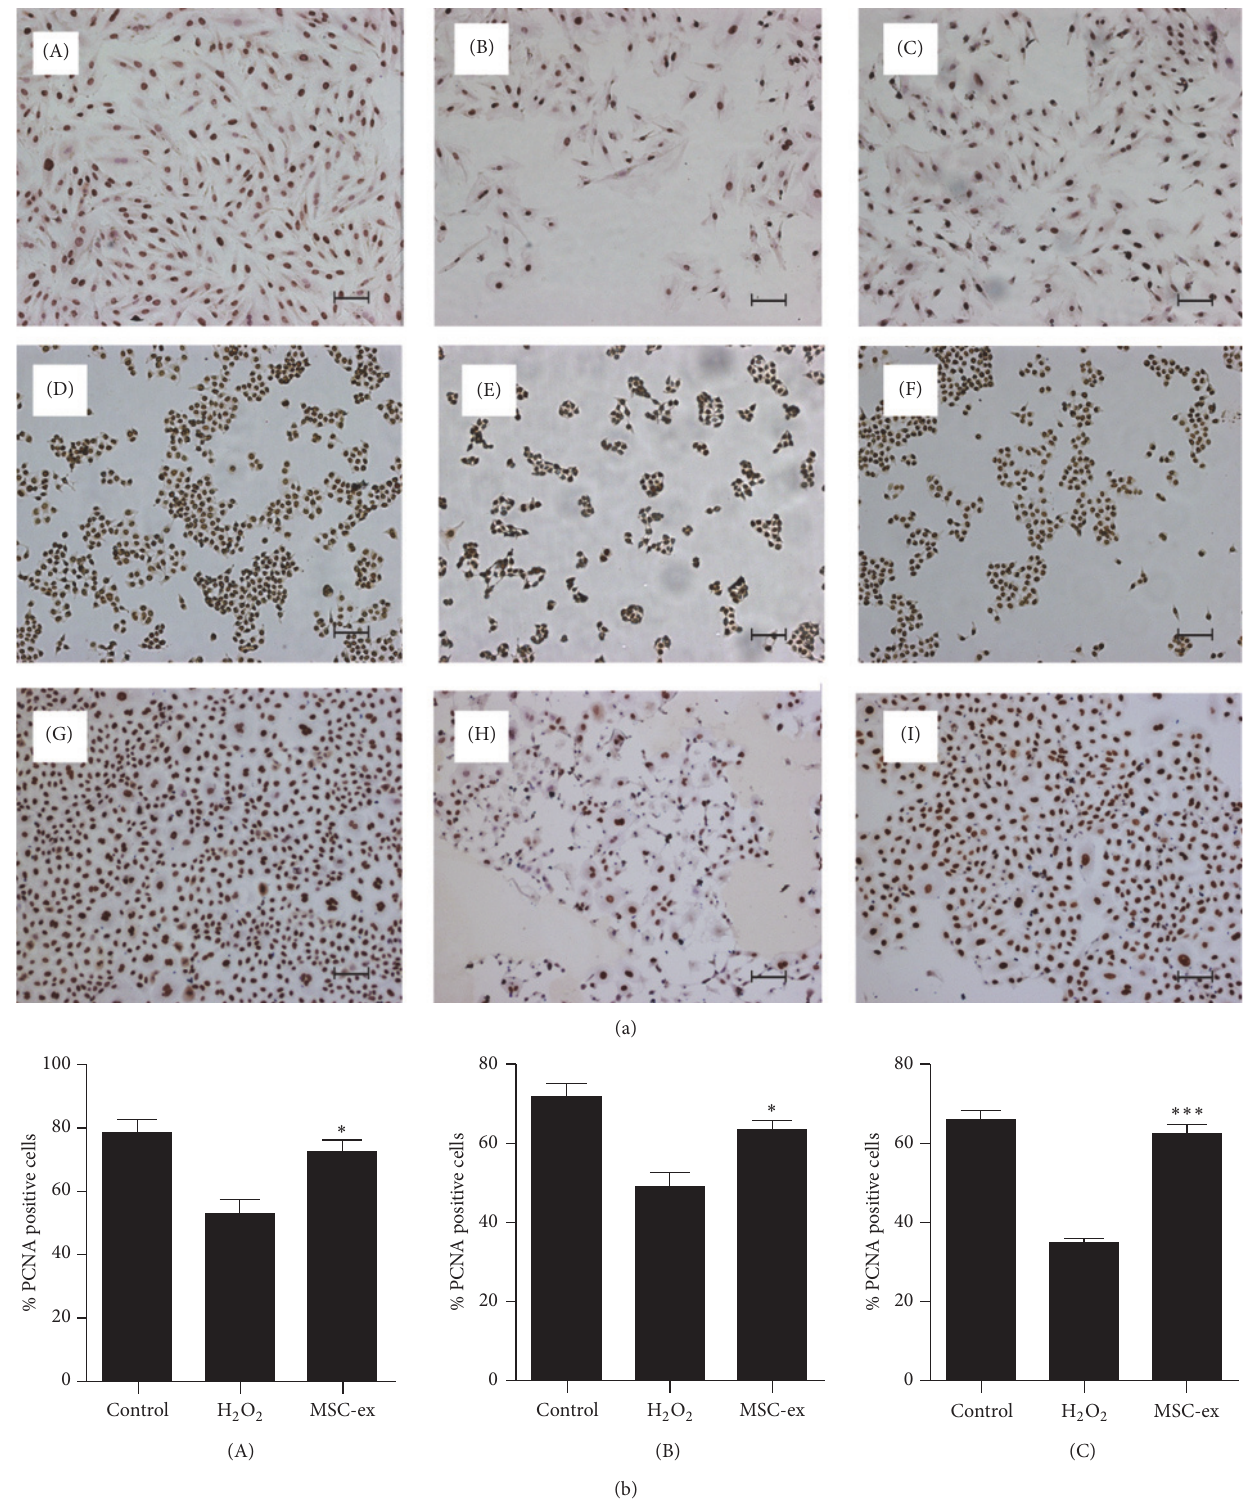
Figure 4: HucMSCs-exosomes promote cell proliferation under oxidative stress. (a) Immunohistochemical staining of proliferative cell nuclear antigen. H9C2(2-1), HL-7702, and NRK-52E cells were pretreated with hucMSCs-exosomes (800 𝜇 g/mL) for 24 hours, followed by exposure to H 2 O 2 (300, 300, and 500 𝜇 M) for different time points (24, 6, and 6 hours). (A–C) H9C2(2-1); (D–F) HL-7702; and (G–I) NRK- 52E. Control (A, D, and G); H 2 O 2 (B, E, and H); and hucMSCs-exosomes (C, F, and I). Scale bar: 100 𝜇 m. (b) Quantitative analysis of the percentage of PCNA-positive cells. ∗ 𝑝 < 0.05 and ∗∗∗ 𝑝 < 0.001 compared to H 2 O 2